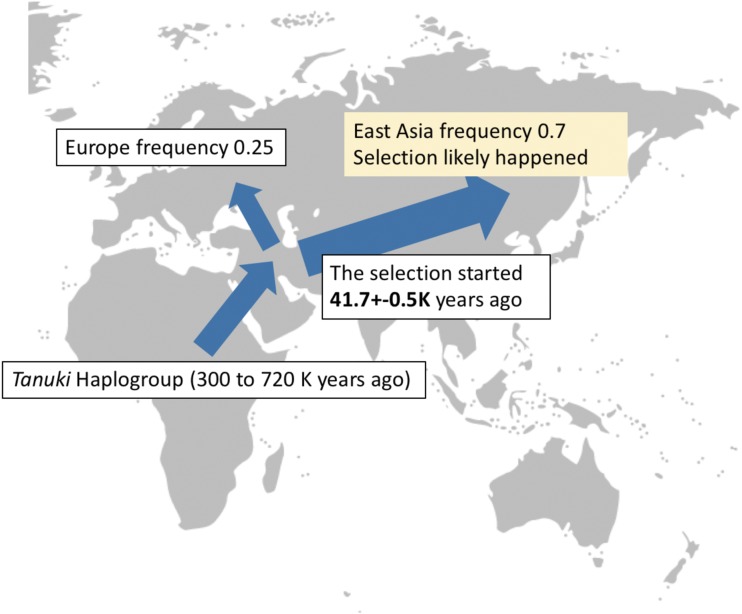
The evolutionary history of the Tanuki haplogroup. Based on our analyses, we argue that the Tanuki haplogroup originated before Out of Africa migrations (∼300K years before present) and spread out to Eurasia. We further argue that in Europe, the frequency of Tanuki haplogroup increased approximately to 0.25 under neutrality. In Asia, the selection on the Tanuki haplogroup started 41.7K years ago and pushed frequency of the Tanuki haplogroup to 0.7 under selection.